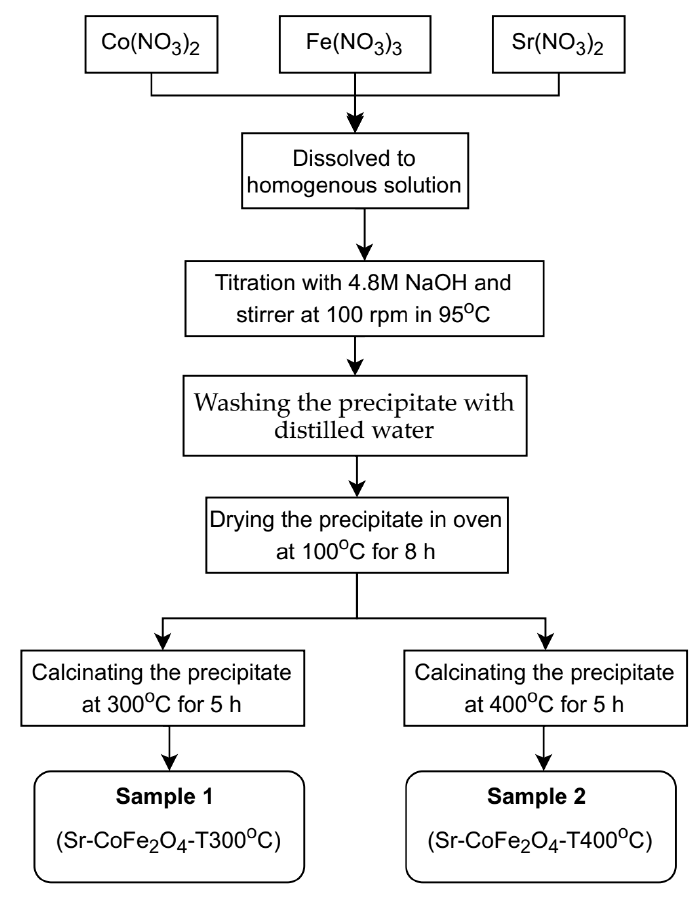
Figure 1. Diagram process of synthesizing nanoparticles Sr-Co Ferrite.